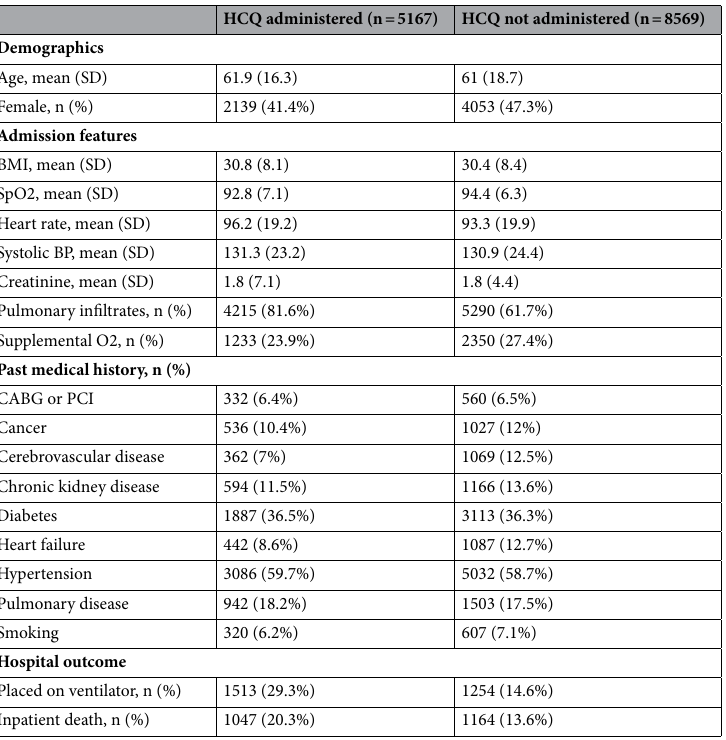
Table 1. Patient characteristics and outcomes by hydroxychloroquine use. BMI body mass index, BP blood pressure, CABG coronary artery bypass grafting, HCQ hydroxychloroquine, n number, PCI percutaneous coronary intervention, O 2 oxygen, SpO 2 oxygen